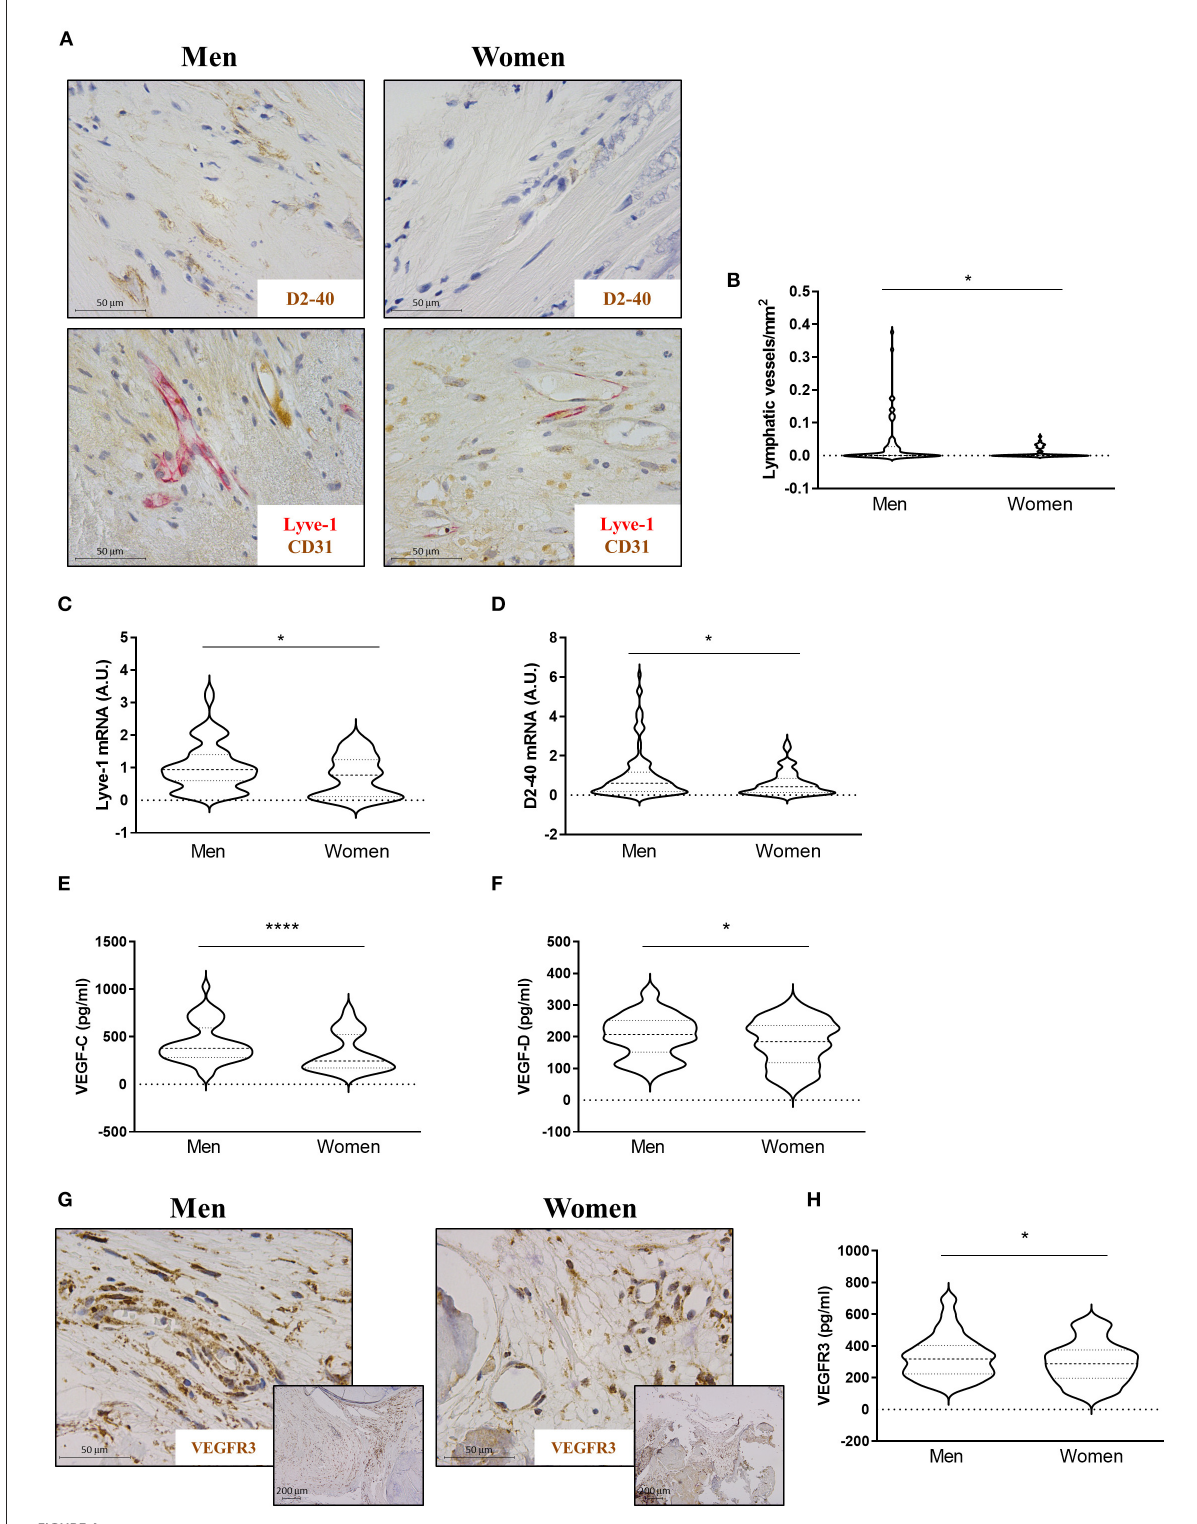
FIGURE4 Sex differences in lymphangiogenesis in AVs from AS patients. Representative microphotographs of AV sections from AS patients immunostained for D2-40 and Lyve-1/CD31 (A) . Total lymphatic vessel density in AVs from men and women was measured by